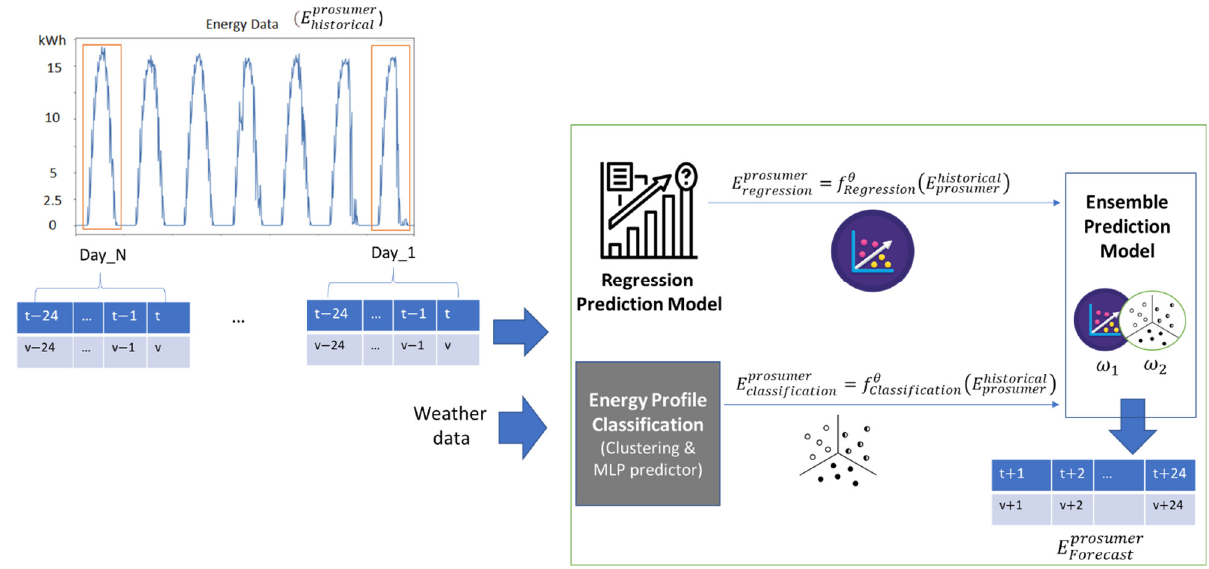
Figure 1. Overview of defined energy-prediction process.